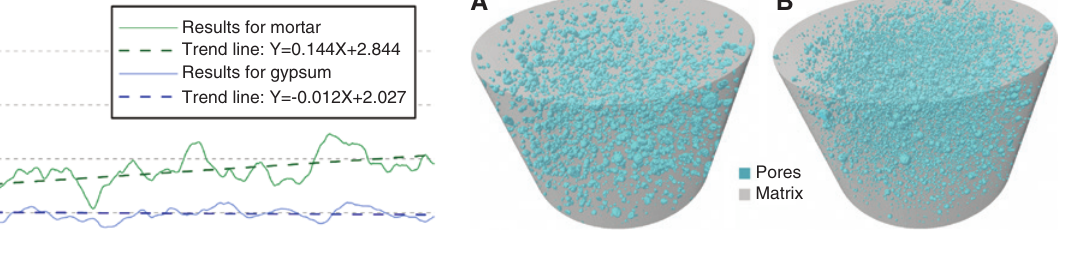
Figure 9: Three-dimensional visualisation of the pores in (A) mortar and (B)